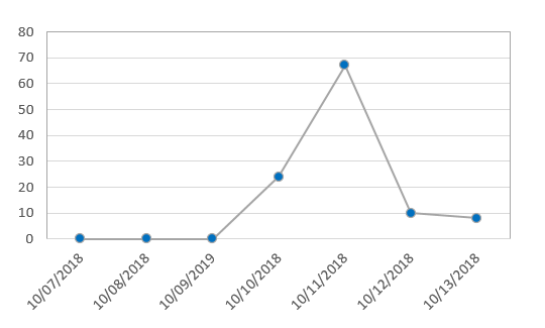
Figure 1. Number of crowdsourced photos of Panama City